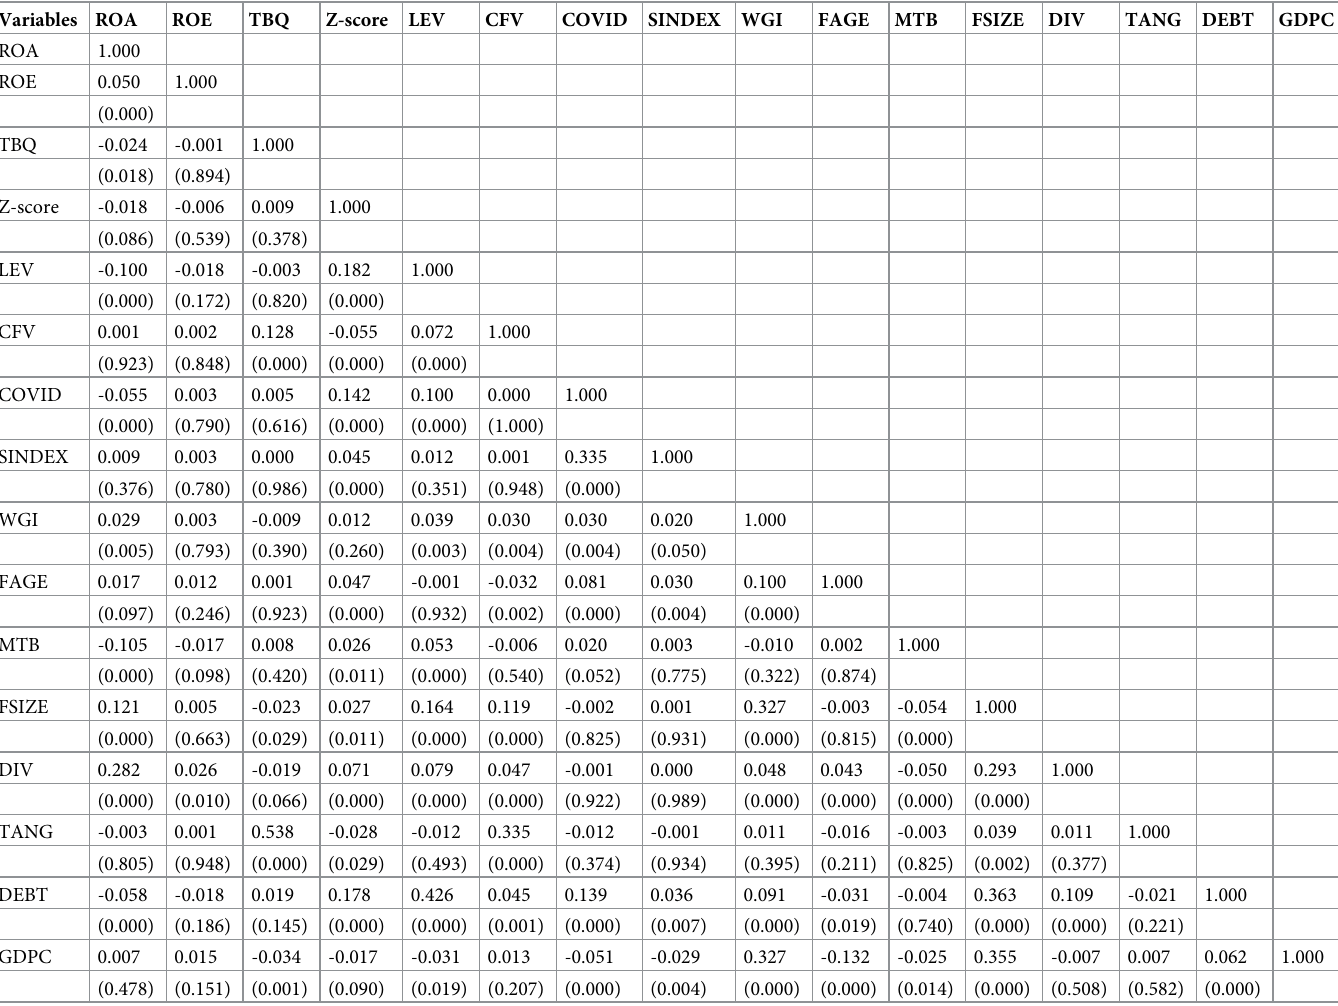
Table 3. Correlation